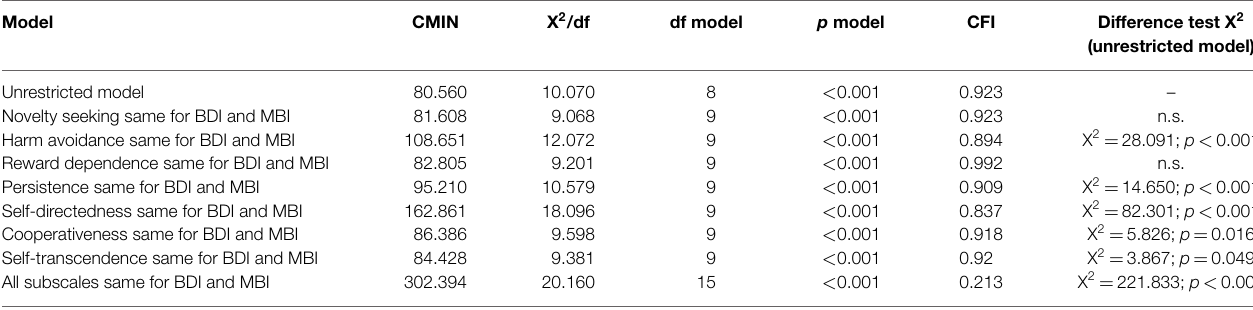
TABLE 5 | Results of the path analyses comparing MBI sum score and BDI 2 for the patient sample